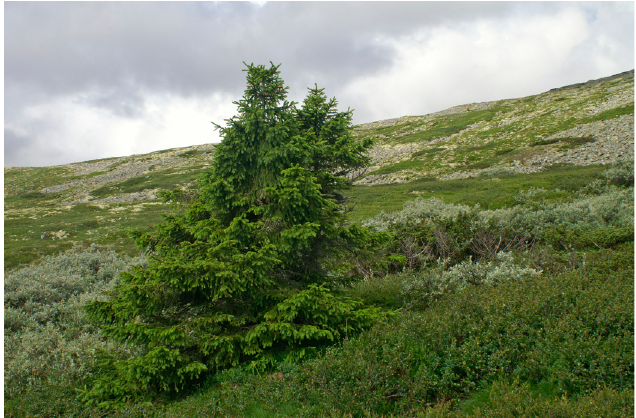
Figure 19: Vigorously growing spruce which marks treeline rise by 185 m since 1915. Prior to that, it persisted as stun- ted krummholz for centuries or even millennia. Mt. Här- jehågna, 1050 m a.s.l. 12 July 2007.